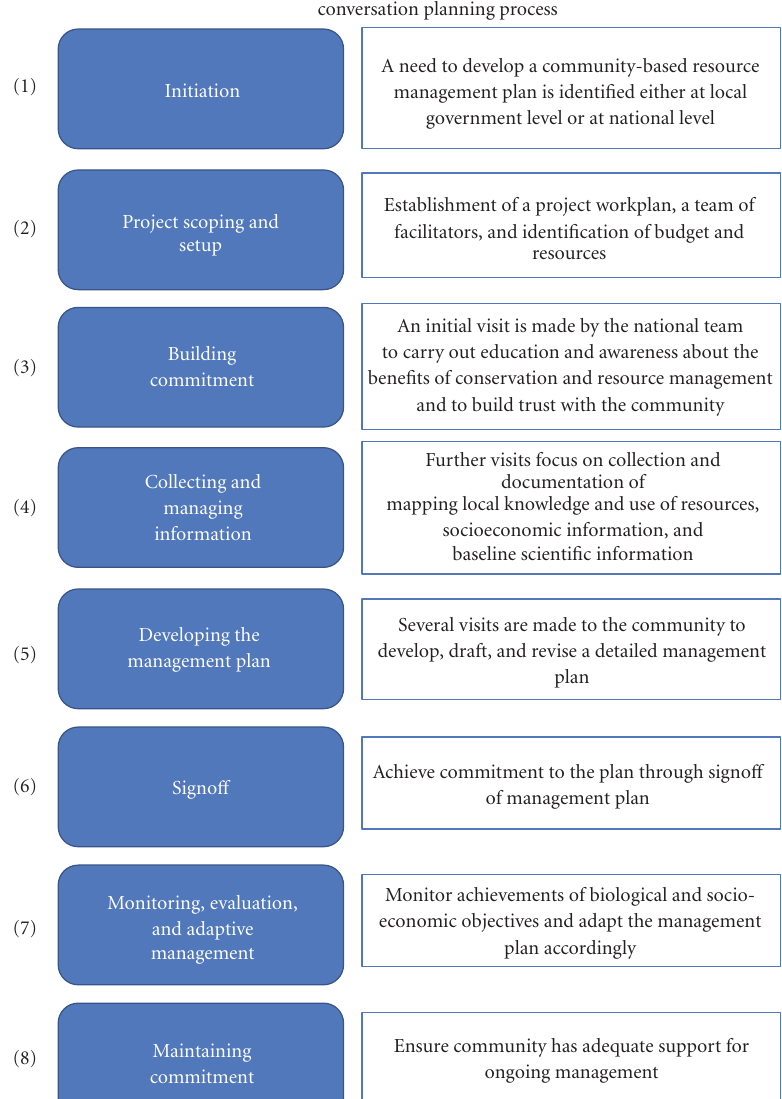
compliance could be achieved within a community through direction from traditional leaders and other respected leaders, accompanied by associated social sanctions. Regulations and legal authority were con- sidered a secondary